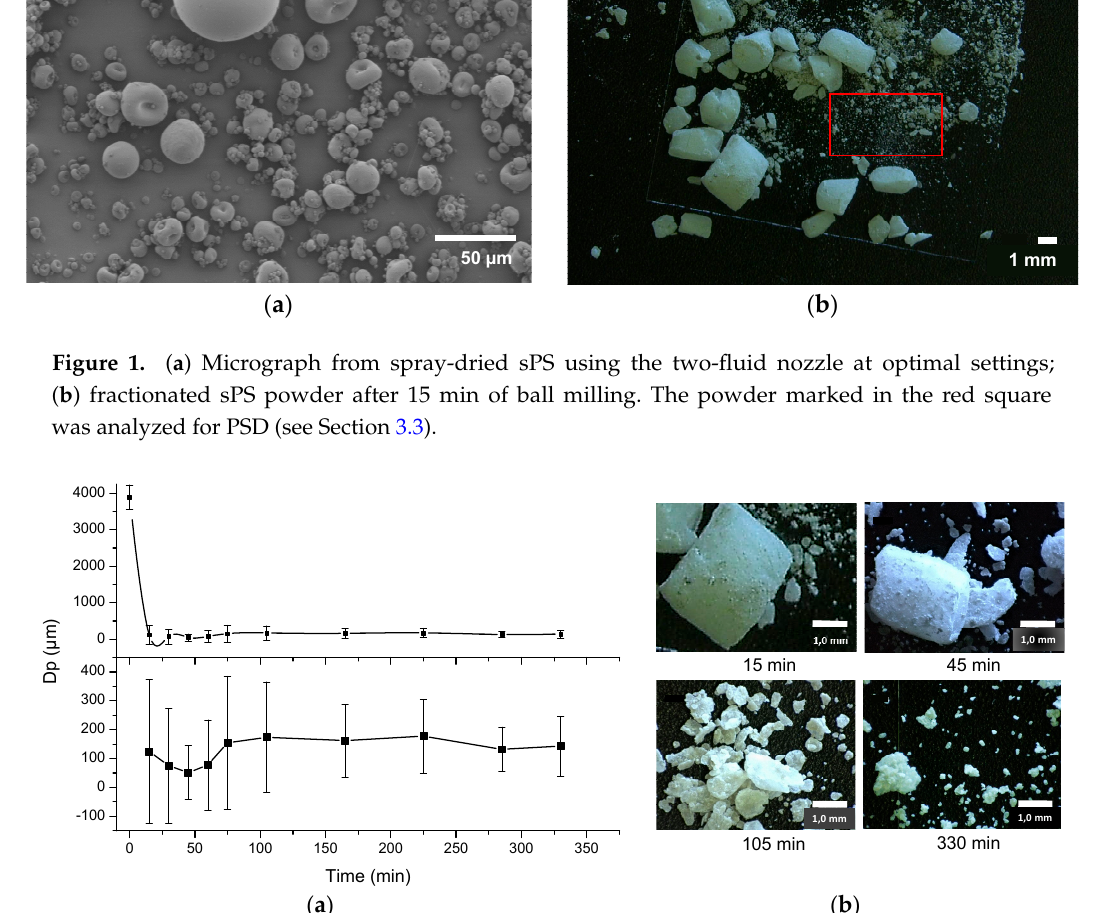
Figure 2. Evolution of average particle size ( a ) and morphology ( b ) of ball milled sPS as function of milling time. The above panel in ( a ) displays the sudden decay in particle size due to immediate fractionation. The lower panel focuses on the fractionation itself. The particle size distribution in the ground material is very broad with angular structures that become flattened into flakes over time. The flattening is clearly visible in ( b ).